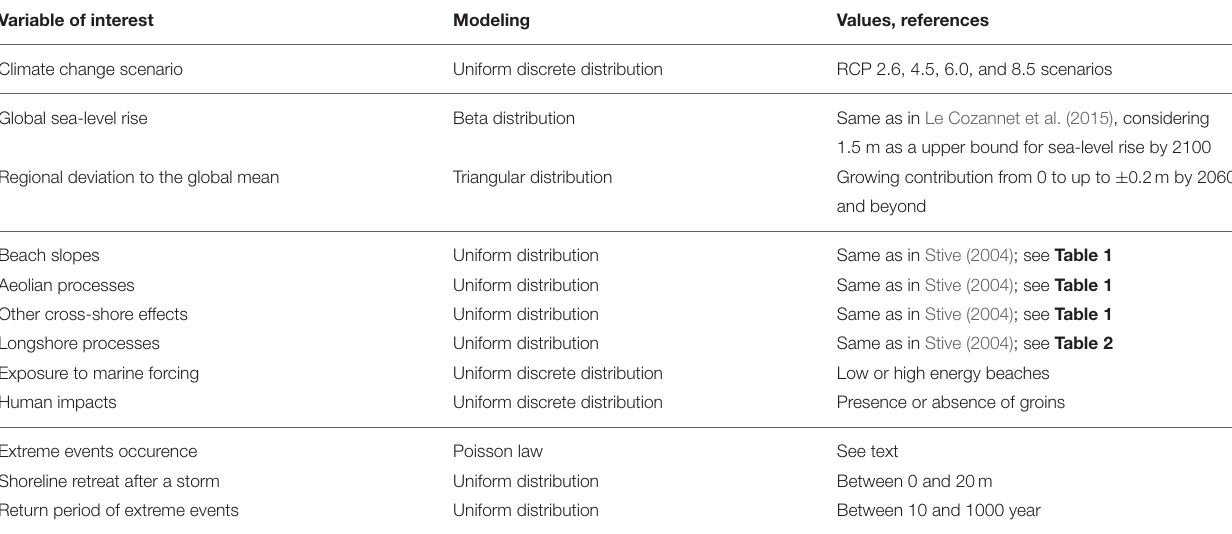
TABLE 3 | Modeling of the different sources of